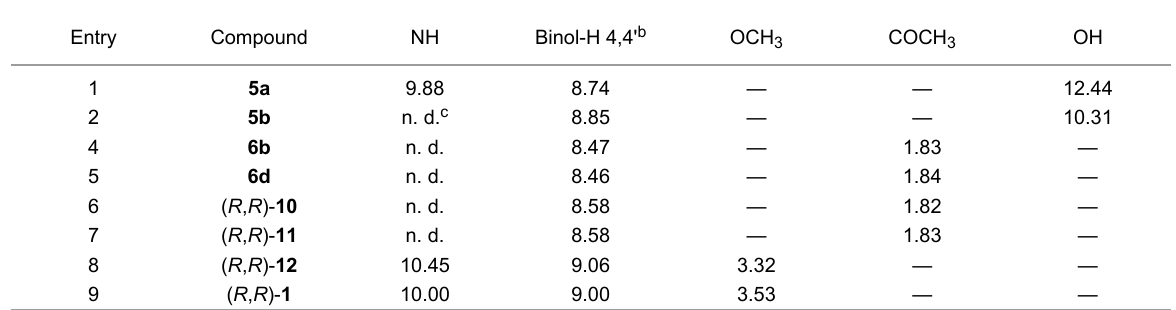
bathochromically shifted shoulder, centered at 320 nm (quite different from ( R , R )- 10 ). The CD spectra (in EtOH) show activity associated with all active UV chromophores and more marked activity for the macrocycle ( R , R )- 10 , with exciton couplet signals greater in intensity than the ones of the other